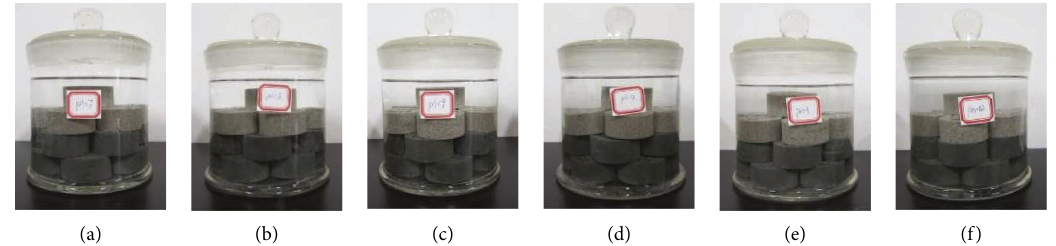
Figure 2: Sandstone corroded specimen. (a) pH � 7; (b) pH � 8; (c) pH � 9; (d) pH � 10; (e) pH � 11; (f) pH � 12.